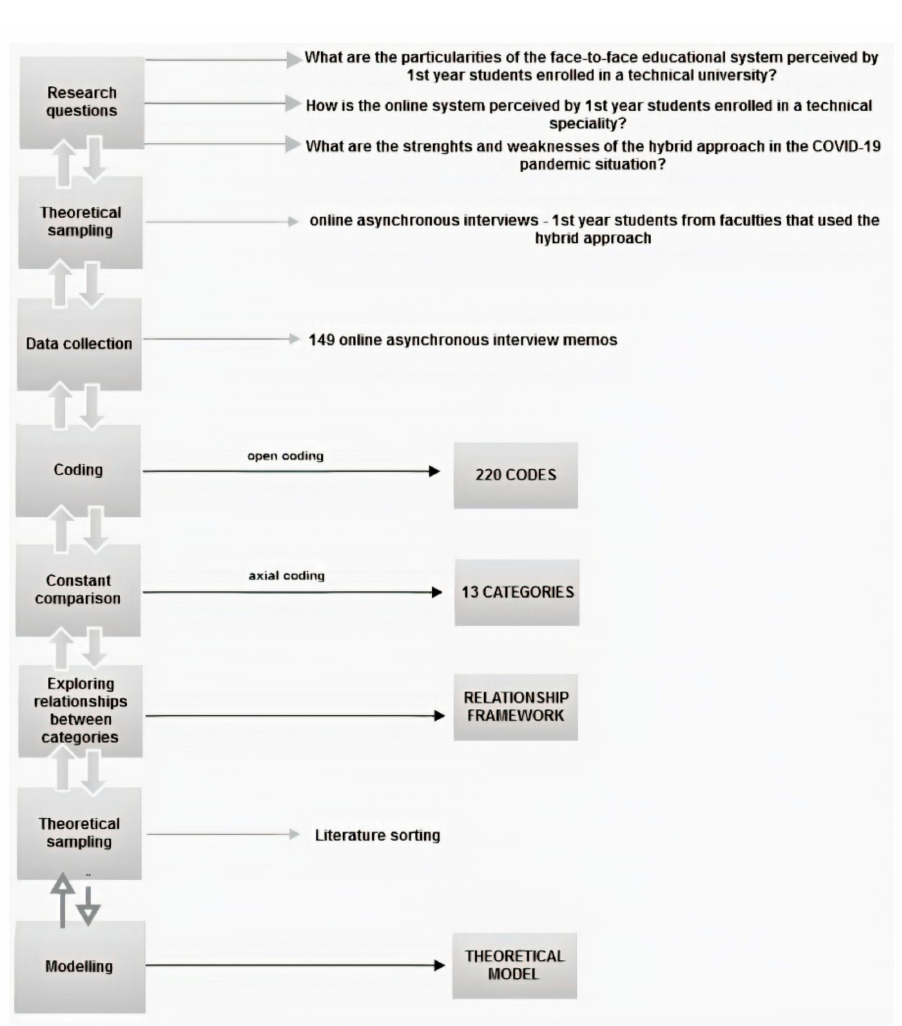
Figure 1. Grounded Theory steps for theoretical